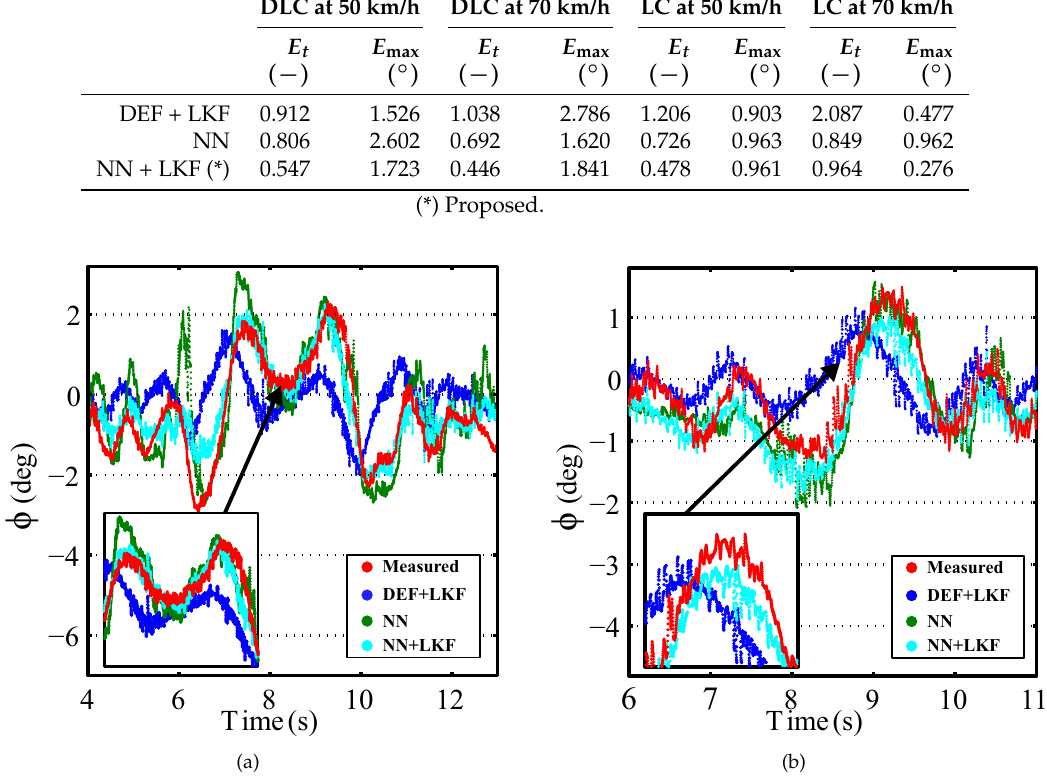
Figure 9. Experimental results for a vehicle traveling at 70 km/h on dry pavement. (red points: measured; blue points: DEF + LKF; green points: NN; cyan points: NN + LKF): ( a ) DLC maneuver and ( b ) LC